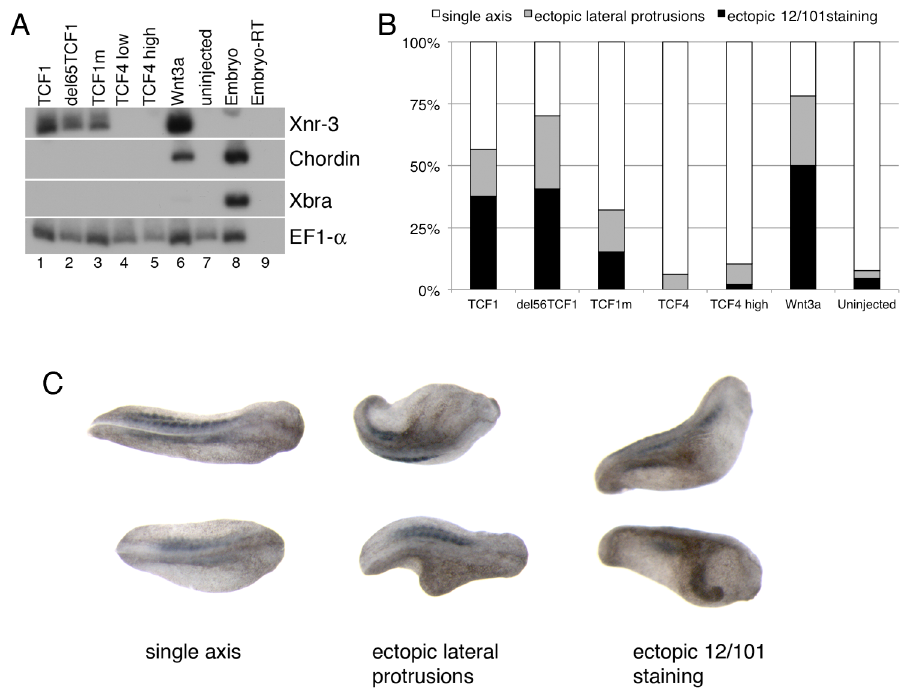
Figure 3. TCF1 activity in Xenopuslaevis explants and embryos. (A) Wnt3a, wild-type and b -catenin-independent mutants of TCF1, but not TCF4, induce expression of the canonical Wnt pathway-responsive gene Xnr3 in ectodermal (animal cap) explants. RT-PCR analysis of animal caps dissected at late blastula stages and cultured until stage 10.5. EF1- a is used as a loading control. The –RT lane contains all reagents except reverse transcriptase, and is used as a negative control. (B) Graph depicting embryonic perturbation by Wnt3a, TCF4, and wild-type and mutant TCF1. Embryos were injected in the ventral marginal zone at early cleavage stages and cultured until late tailbud stages. For (A) and (B), 1 ng (TCF4 high) or 500 pg (TCF1, del65TCF1, TCF1m, TCF4low, Wnt3a) of each RNA was injected, as listed. (C) Representative embryos recorded in the graph shown in (B). Dorsal views; anterior is to right. All embryos in (C) were injected with RNA encoding del65TCF1. Staining with the 12/101 antibody, which recognizes a somite specific epitope, was used to assess axis